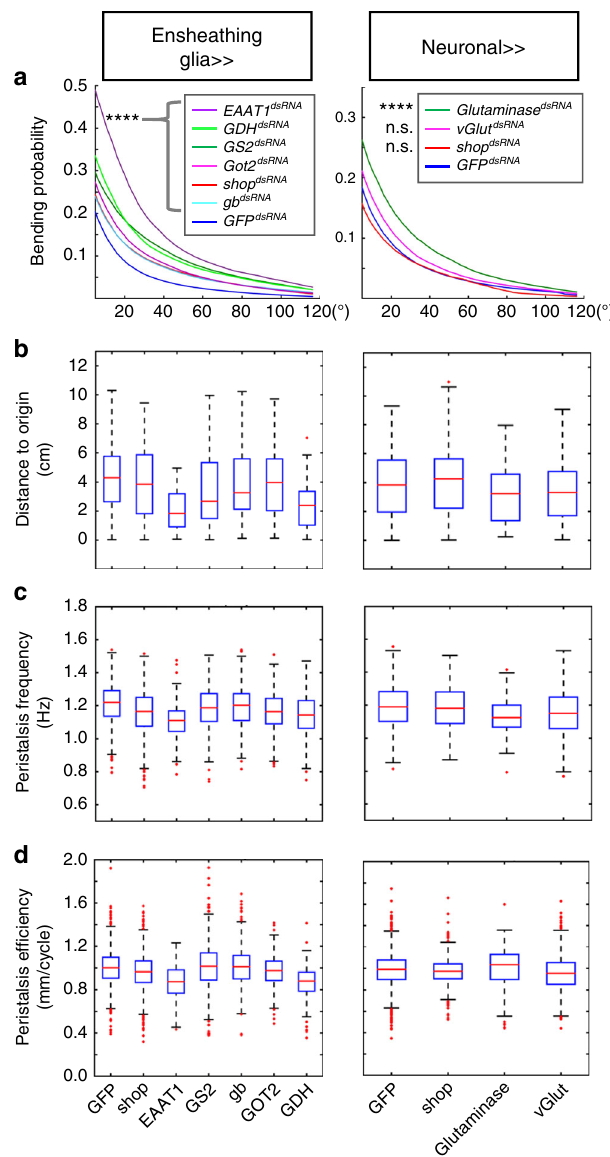
Fig. 6 Glutamate metabolism in ensheathing glia fi ne tunes larval locomotion. The function of the following genes required for the glutamate – glutamine cycle was silenced in ensheathing glia ( R83E12-Gal4 ): shopper, Eaat1, Gs2, gb, Got2, and Gdh , while GFP dsRNA expression served as control. The neuronal side of the cycle was probed by suppression of Glutaminase and vGlut using nsyb-Gal4 . shopper and GFP expression were silenced as controls. a Bending rates: suppression of enzymes of the glutamate – glutamine cycle in ensheathing glia or neurons causes signi fi cantly elevated head bending. Note the neuronal knockdown of shopper does not alter head bending. Silencing of vGlut results in a moderate increase of head bending frequency only. b Box plots showing the distance to origin covered by larvae of the genotype indicated. c , d Box plots showing the peristalsis frequency and ef fi cacy reveal statistically signi fi cant differences in peristalsis for all genes encoding enzymes acting in the glutamate – glutamine cycle. Note that suppression of Eaat1 and Gdh affects bending rates and peristalsis most strongly. Box plots represent the fi rst and third quartile as well as the median. Whiskers contain values within 1.5 times of the interquartile range, and outliers are marked as red crosses, **** p < 0.001, n.s.: not signi fi cant, Wilcoxon rank-sum test. Due to